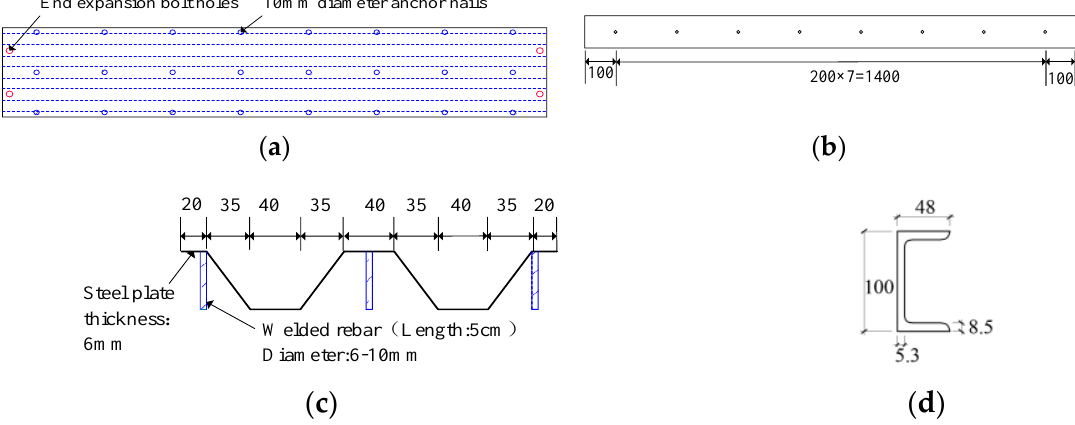
Figure 5. Steel plate processing diagram. ( a ) Distribution of anchor bolts and bolt holes; ( b ) Distribution of slotted steel bolt holes; ( c ) Corrugated steel plate cross-sectional drawing; ( d ) Cross-sectional view of channel steel.